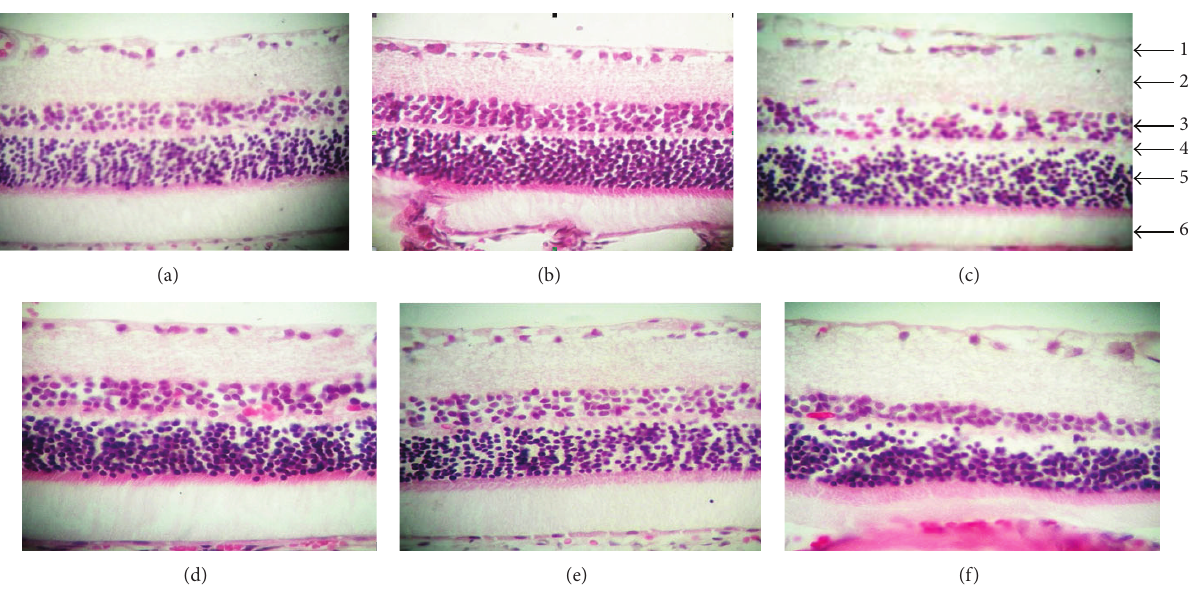
Figure 1: The morphology of retinal structure under light microscope (hematoxylin-eosin staining × 400). (a–c) Control group; (d–f) diabetic group. Numbers 1–6 represent layers of ganglion cell, inner plexiform, inner nuclear, outer plexiform, outer nuclear, rods, and